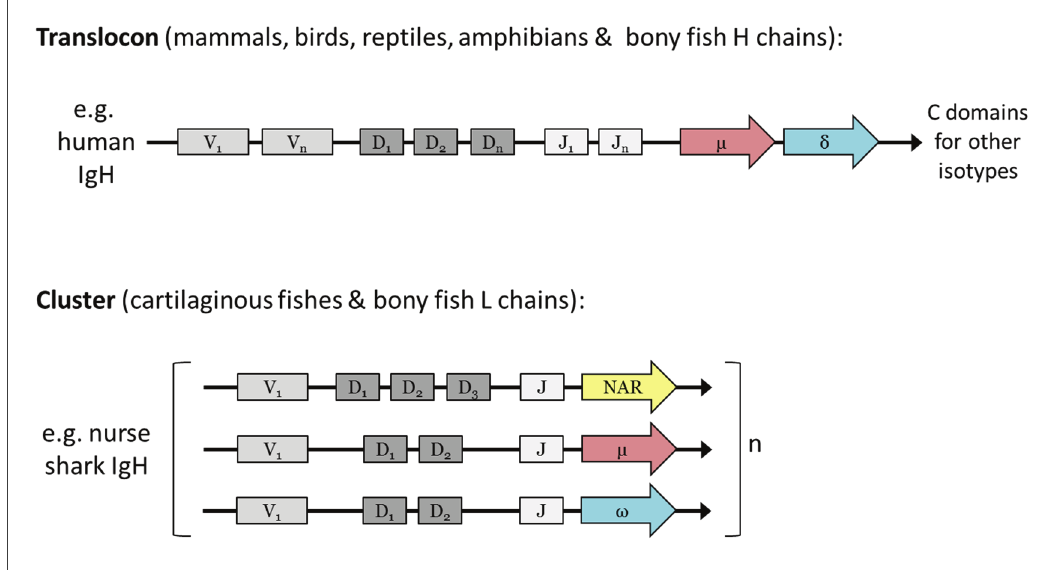
Figure 2. The immunoglobulins of most species are found in the translocon organisation typified by mammals however those of the cartilaginous fishes are found in the so-called “cluster” configuration with only the constant (C) domains for one isotype 3' of a single variable (V) segment, 1–3 diversity (D) segments and a single joining (J) segment [8]; rearrangement occurs almost exclusively within a cluster and not between adjacent clusters [9]. The Igs of bony fishes are mixed, with their heavy chain loci being present in the translocon configuration but the light chain loci in the cluster